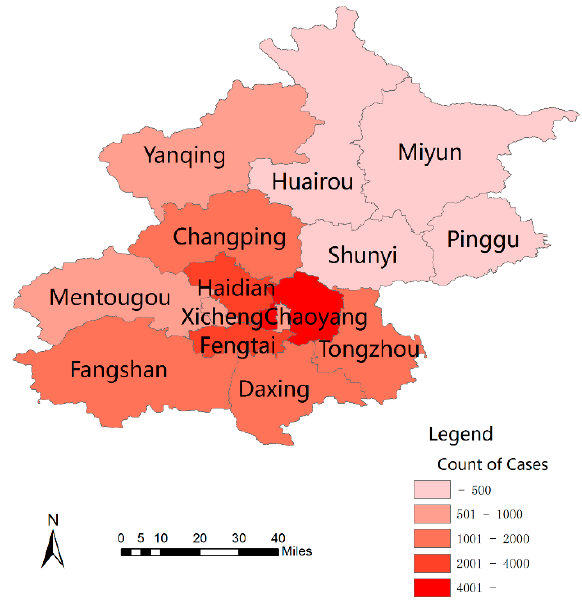
Figure 1. The distribution of scarlet fever cases in different districts in Beijing, 2005–2014. Table 2. Socio-demographic characteristics of scarlet fever patients in Beijing,